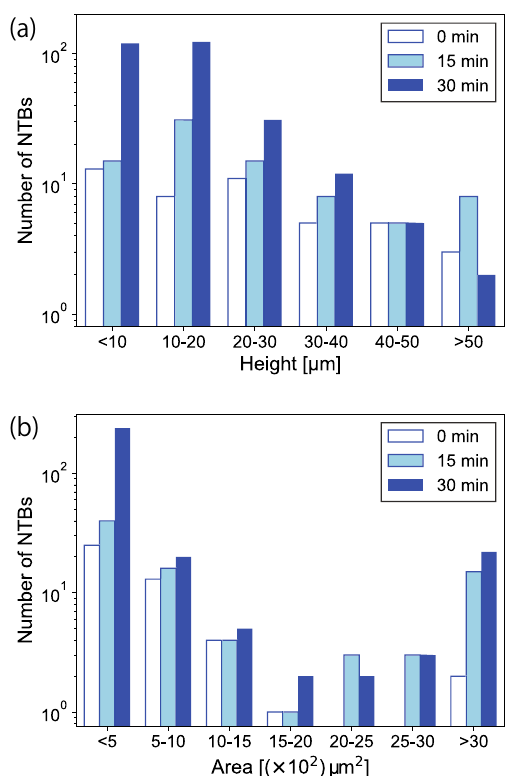
Figure 9. Evolution of ( a ) the height and ( b ) area distribution of NTBs during the exposure to He plasma with W co-deposition measured by